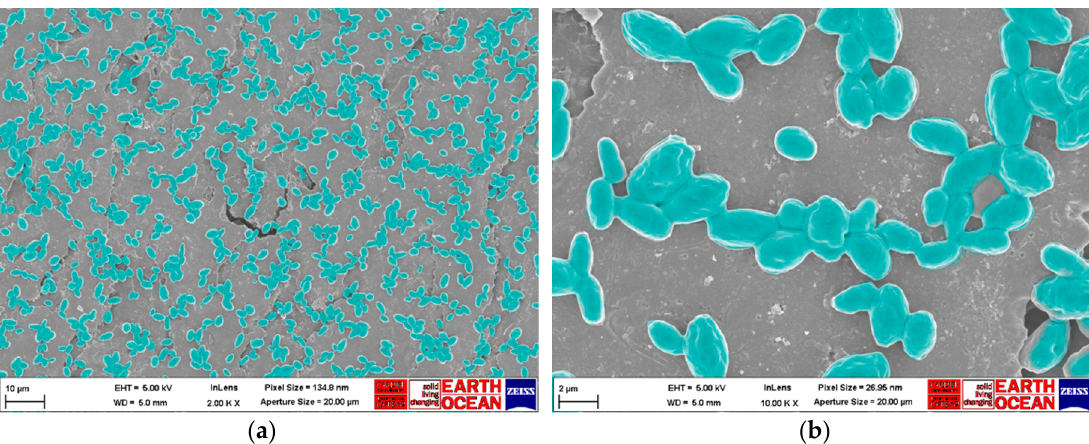
Figure 1. Scanning electron microscope images of C. auris organic load (OL) dry surface biofilm: ( a ) × 2000 magnification; ( b ) × 10,000 magnification. The images presented are representative for the whole disc surface. Observations were made on three independent triplicates of C. auris dry-biofilm, and whole disc surface (~0.8 cm 2 ) was investigated each time with × 500 magnification. Images of dry surface biofilm (DSB) were colored in green to help visualization and contrast using GNU Image manipulation program (GIMP 2.8) software. Images were not otherwise altered.